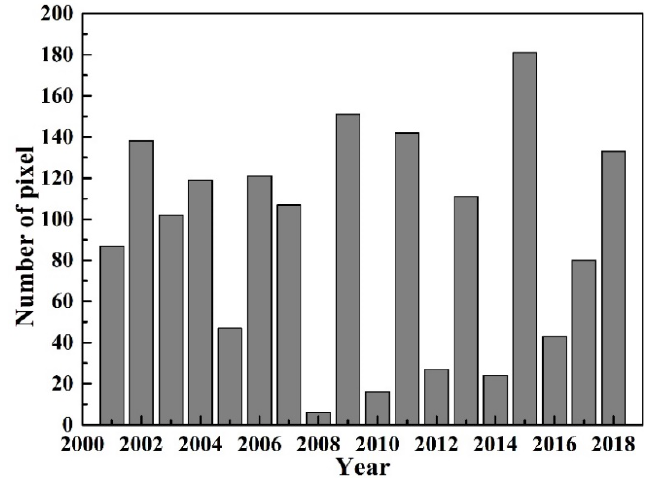
Figure 4. Number of pixels with more than 6 days data available from the 2001 to 2018 winter monthly average LST (land surface temperature) of the Purog Kangri ice field.